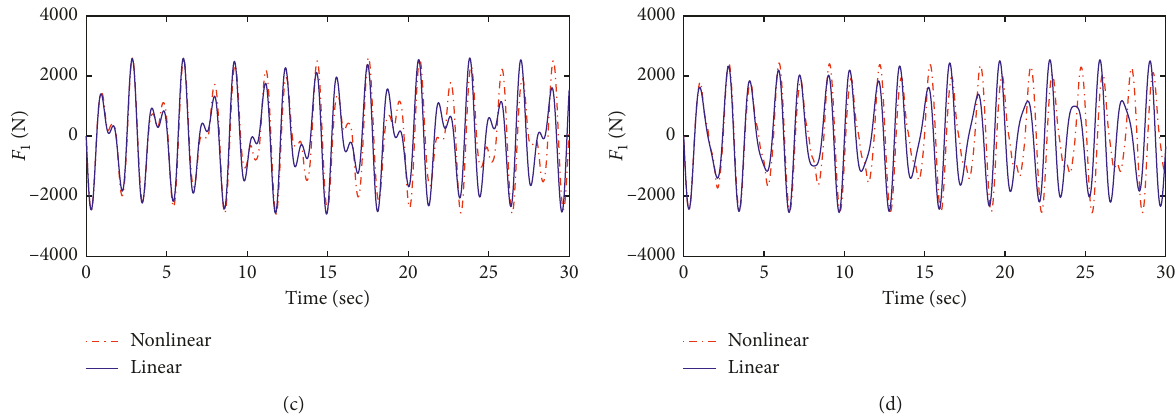
Figure 17: Time history of the resultant hydrodynamic force in the θ � 0 direction under the lateral harmonic excitation for z � 0 . 2 m (a), 0.4m (b), 0.6m (c), and 0.8m (d), respectively. r 1